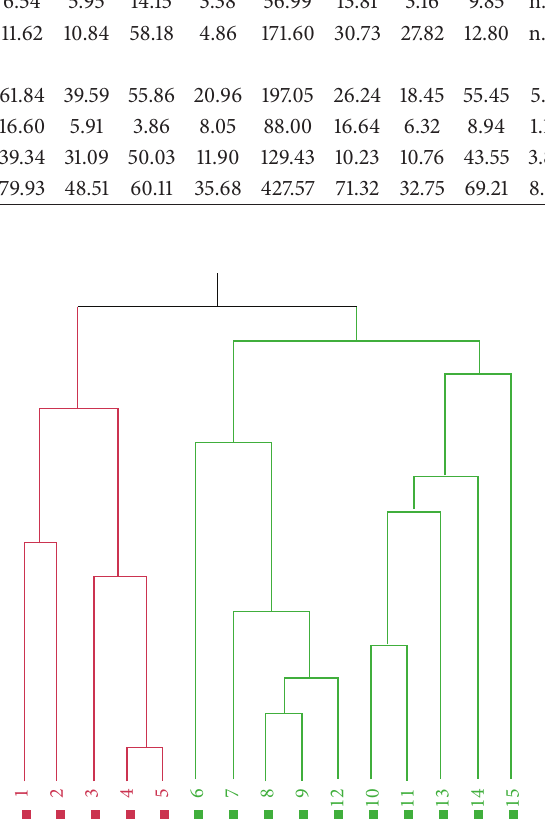
Figure 2: Dendrogram of cluster analysis for Korba (red) and Raipur (green)